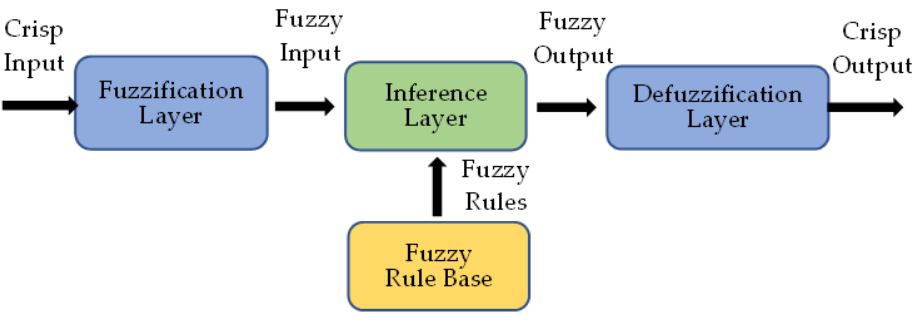
Figure 1. Schematic demonstration of a FIS.